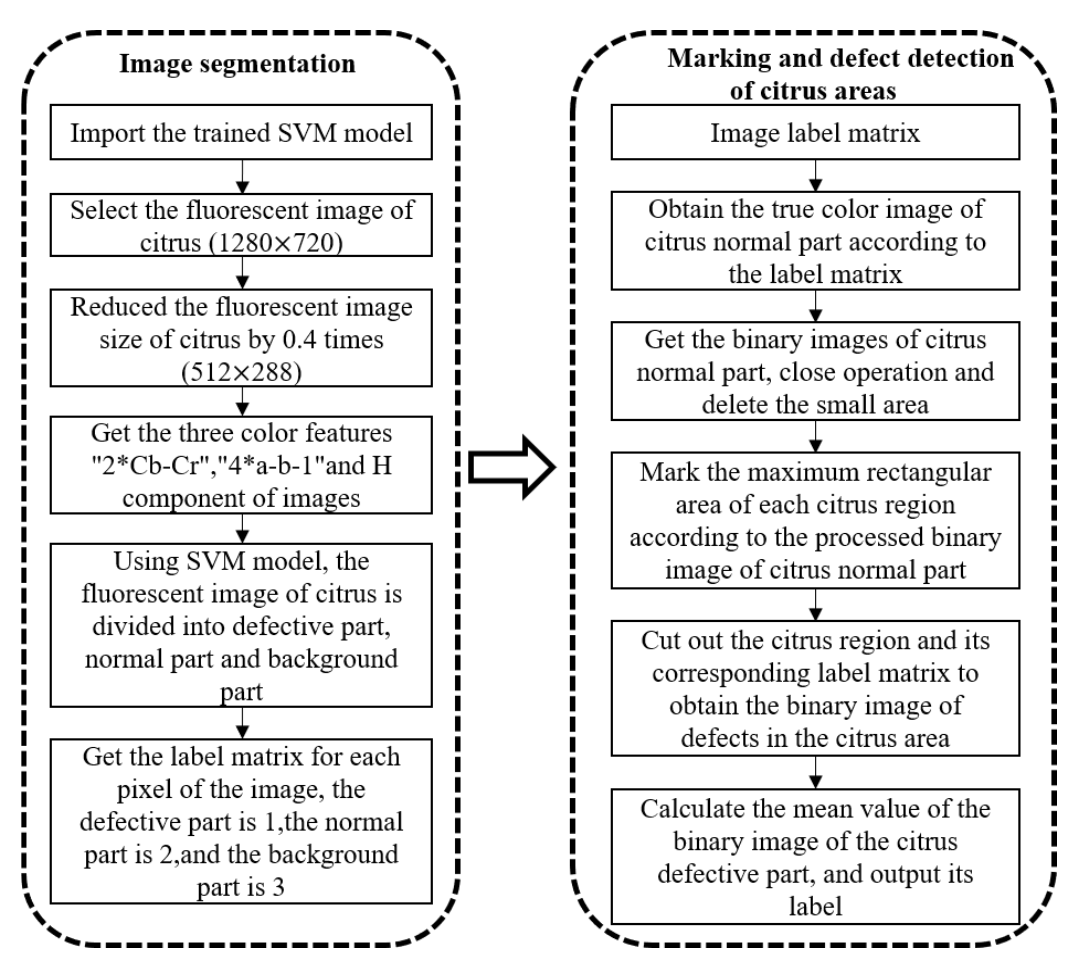
Figure 10. Fluorescence detection algorithm flow chart of citrus surface defects.